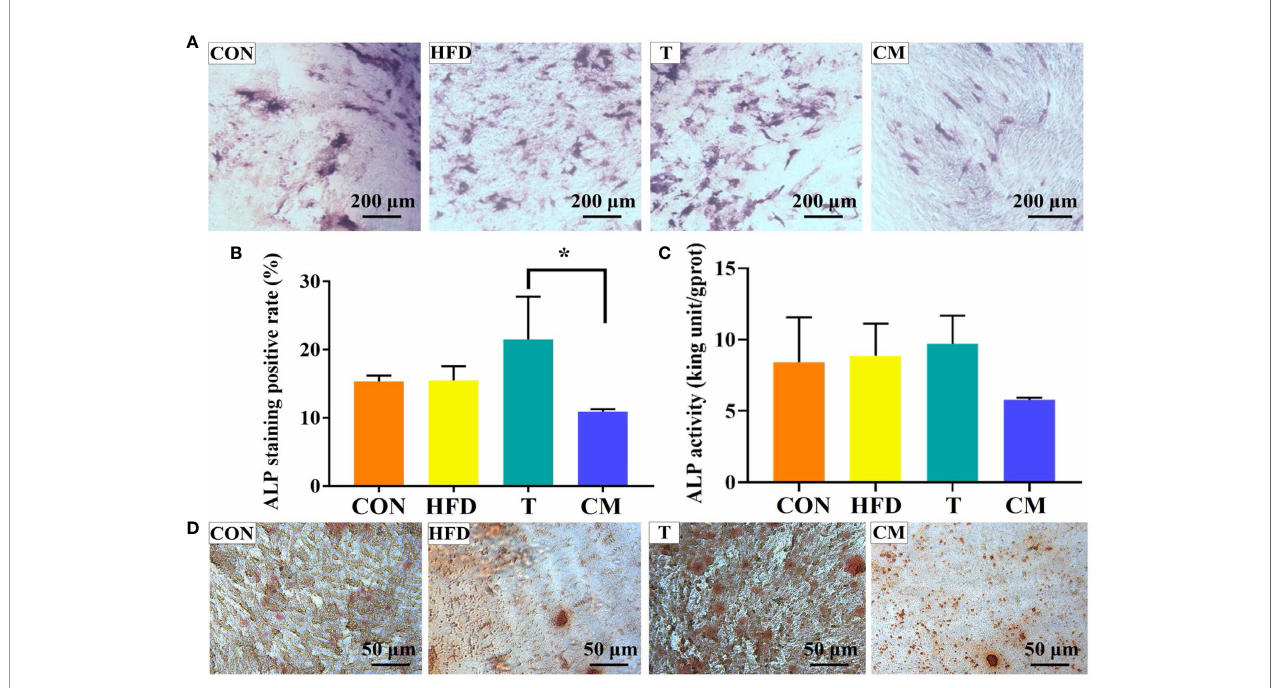
FIGURE 6 | (A) ALP activity of MC3T3-E1 cells on different groups after 14 d of culture. (B) ImageJ was used to quantify the ALP staining results (* p < 0.05). (C) ALP test after 14 d for each group using the ALP assay kit. (D) The mineralized nodules were stained with ARS after 14